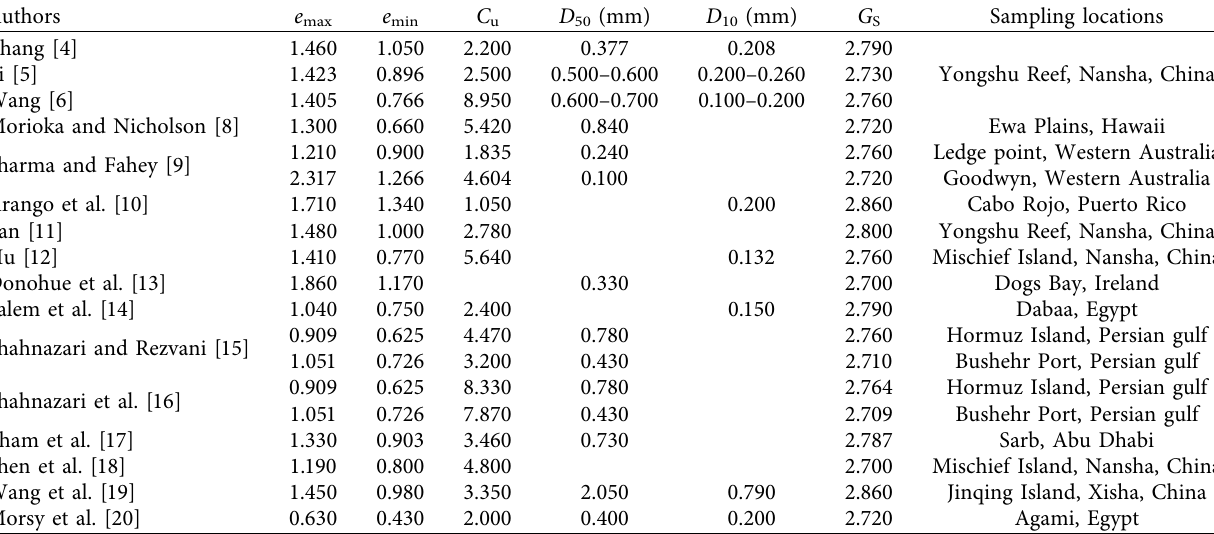
Figure 1: Distribution of coral reefs in the world [3]. Table 1: Physical parameters of calcareous